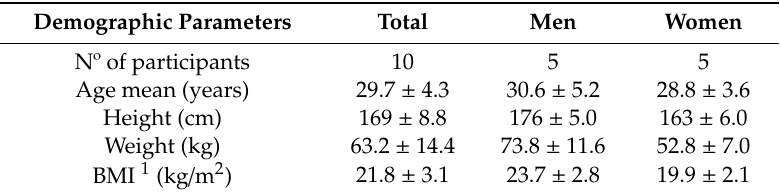
Table 2. Anthropometric data of the participants included in the study. Demographic